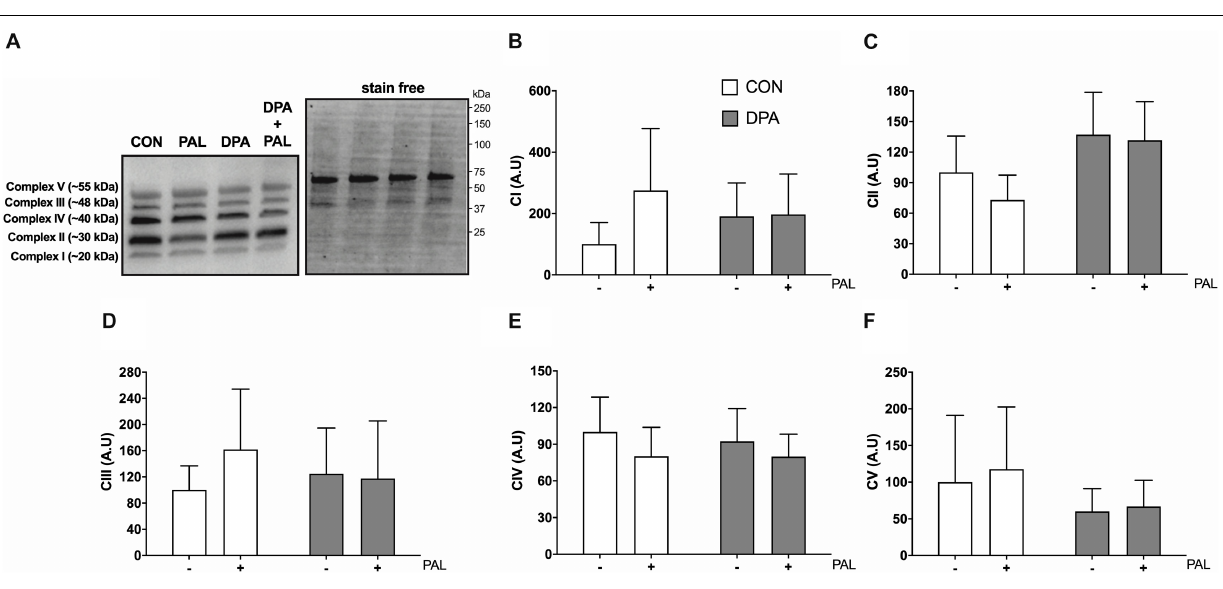
align with previous data in differentiated myotubes